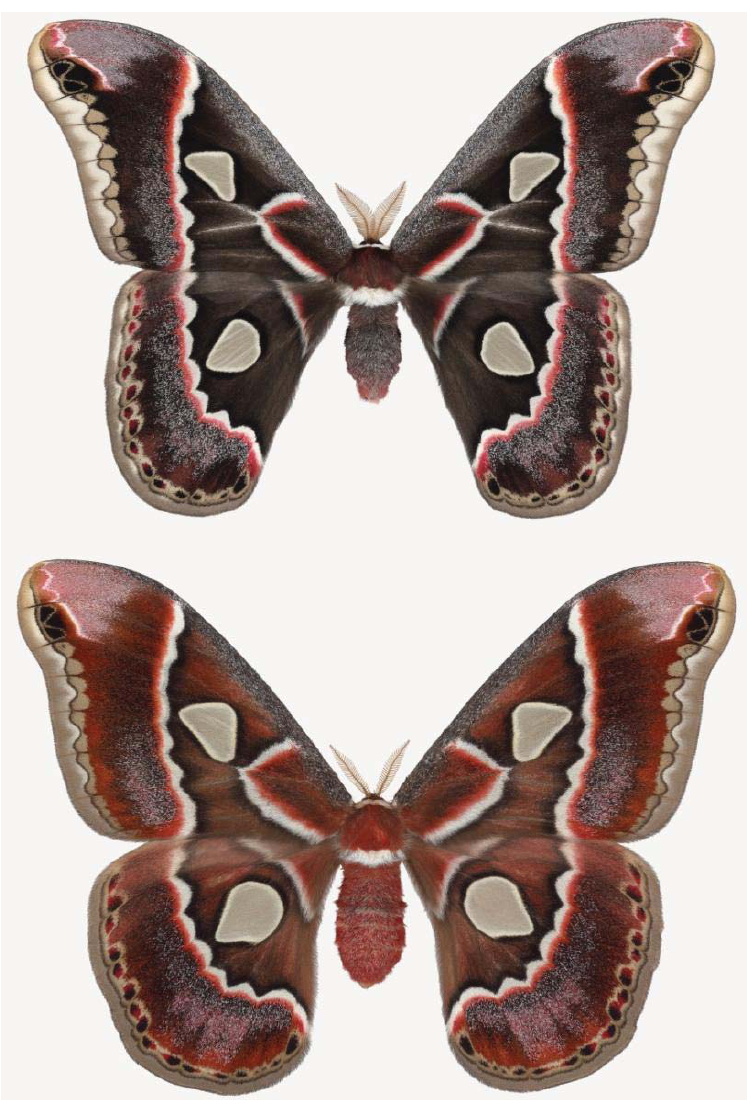
Figure 7. A male (upper) and female (lower) Rothschildia cincta silk moths.